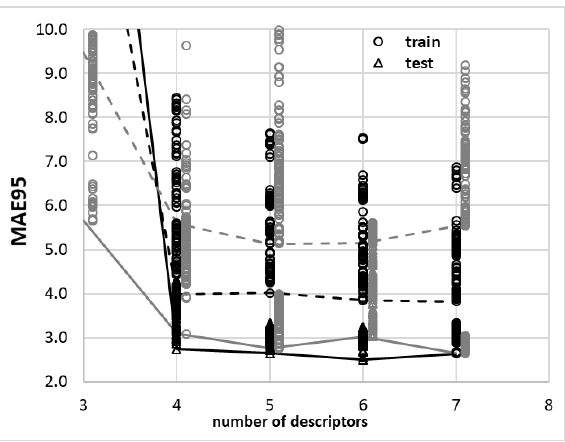
Figure 10. Representation of top 100 models for each number of the descriptors used in the MLR equation. Dotted and solid lines characterize the lowest values of MEA95 for train and test sets, respectively. Black ink was used for the presentation of models derived based on properties of edaravone in DES modeled as in ion pairs, while gray colors represent molecular models of either ETA or GLE.